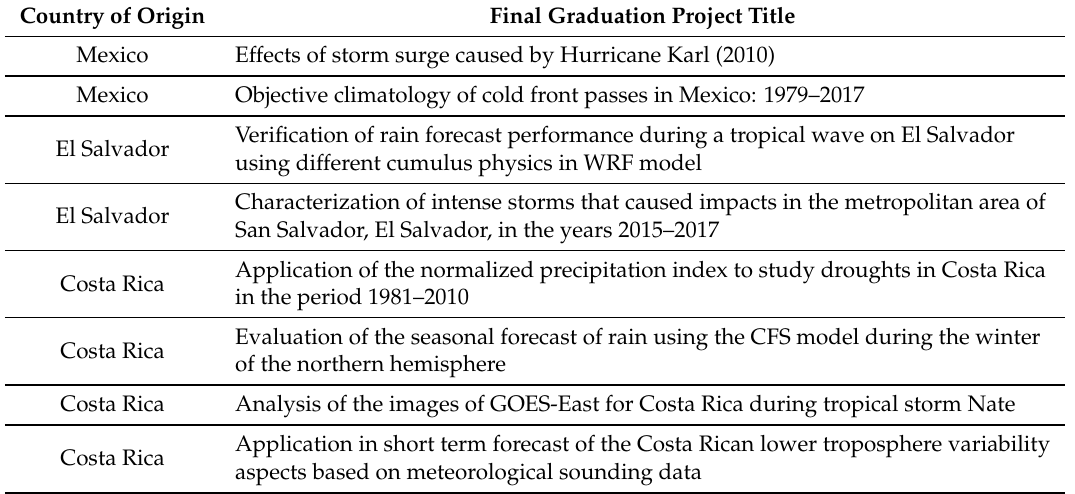
Table 1. In this table the titles of the FGPs for the first generation of students is presented. The country of origin of the student is shown in the left column. It is important to remark that the titles are originally in Spanish and were translated to English for this